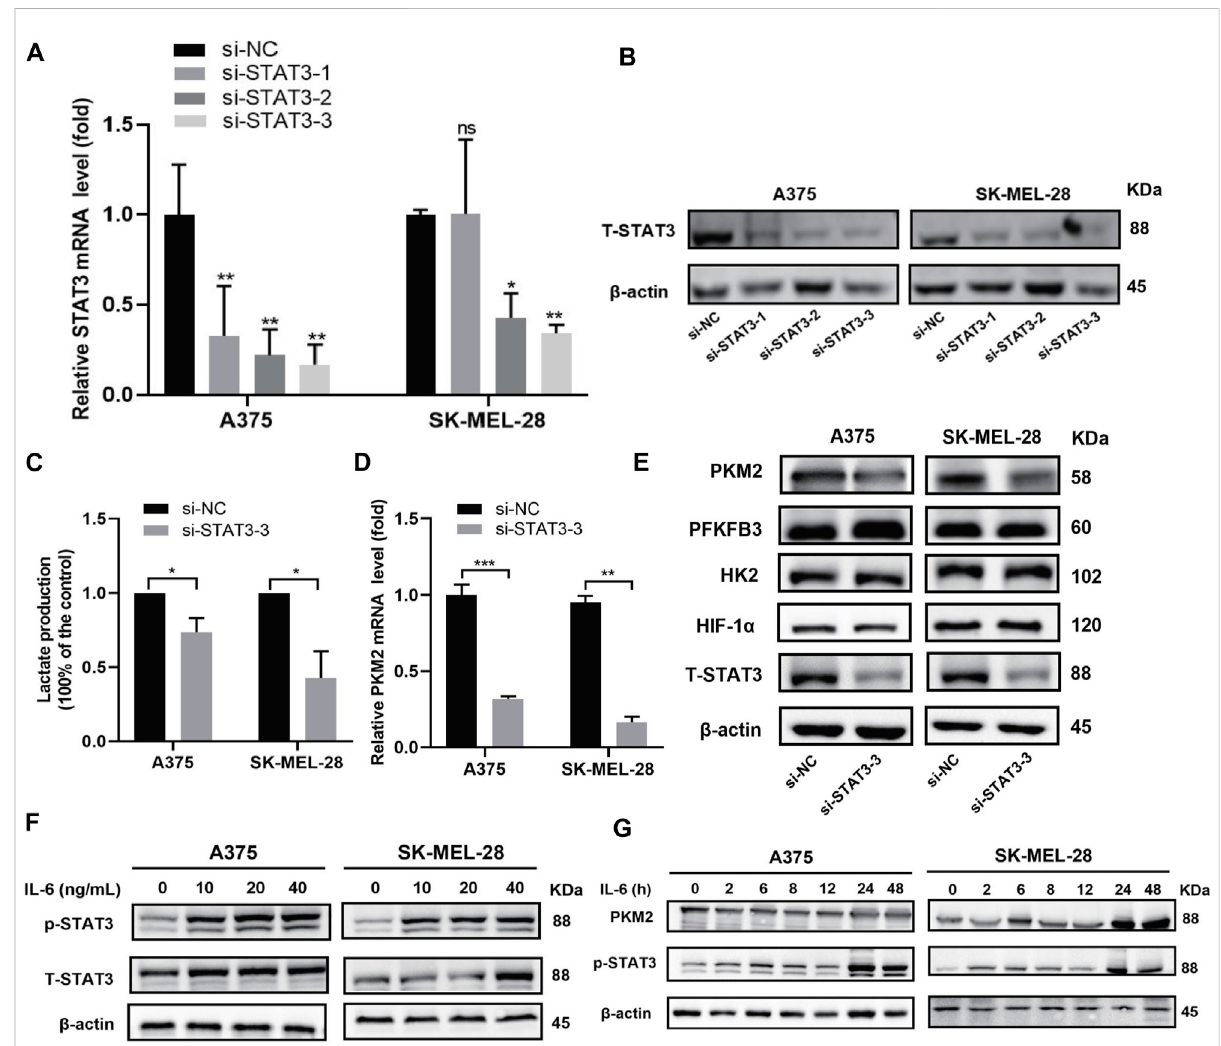
FIGURE 4 Effect of STAT3 on glycolysis and PKM2 expression in A375 and SK-MEL-28 cells. (A) Relative mRNA expression of STAT3 was detected by RT- qPCRassayaftertransfectedfor48 h.Quantitativedataarepresentedasthemean±SDoffourindependentexperiments. (B) Theproteinexpression ofSTAT3wasdetectedbywestern blotassay after beingtransfected for72 h. (C) Lactateproductionofbothcells. Quantitativedataare presentedas the mean ± SD of three independent experiments. (D) Relative mRNA expression of PKM2 was detected by RT-qPCR assay. Data are presented asthemean±SDofthreeindependentexperiments,exceptRT-qPCRassayinSK-MEL-28cells(N=2). (E) ProteinexpressionofHK2,PFKFB3,HIF1 α , and PKM2 was detected by western blot assay. (F) Western blot analysis of protein expressions of STAT3 and p-STAT3. Both cells were treated with a range concentration of recombinant human IL-6 for 48 h. (G) Western blot analysis of protein expressions of PKM2 and p-STAT3. Both cells were treated with 20 ng/ml recombinant human IL-6 for a range of duration times. “ * ” means p < 0.05, “ ** ” means p < 0.01, “ *** ” means p < 0.001, and n. s., not signi fi cant ( p >